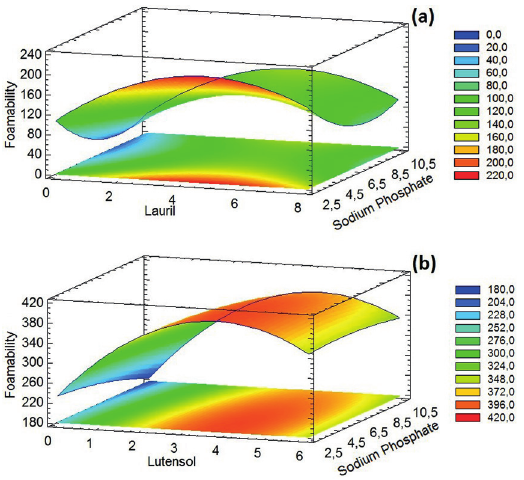
Figure 4: Response surfaces for foamability of solutions with different concentrations of Na to remain constant 16,17 . Na